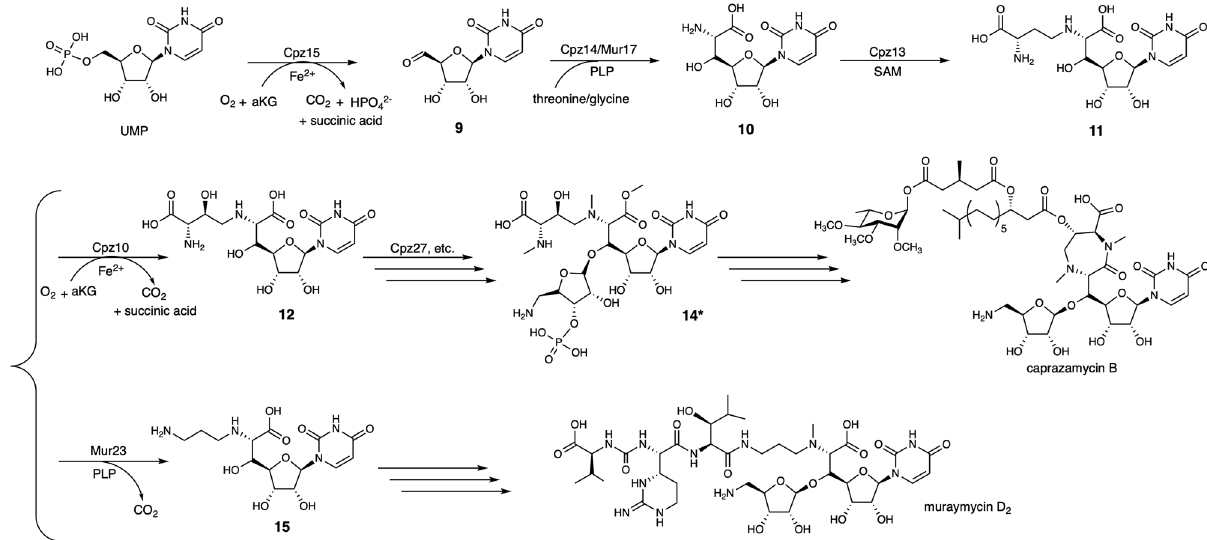
Fig. 7 Biosynthesis schemes of caprazamycin and muraymycin. A Compound 11 stands at a watershed, of which β -hydroxylation catalyzed by Cpz10 permits seven-membered diazepanone ring formation and subsequent acylation to a fully-active caprazamycin or decarboxylation catalyzed by Mur23 directs the synthesis otherwise toward muraymycin. Compound 14 * is compound 14 with a OH group at its β C